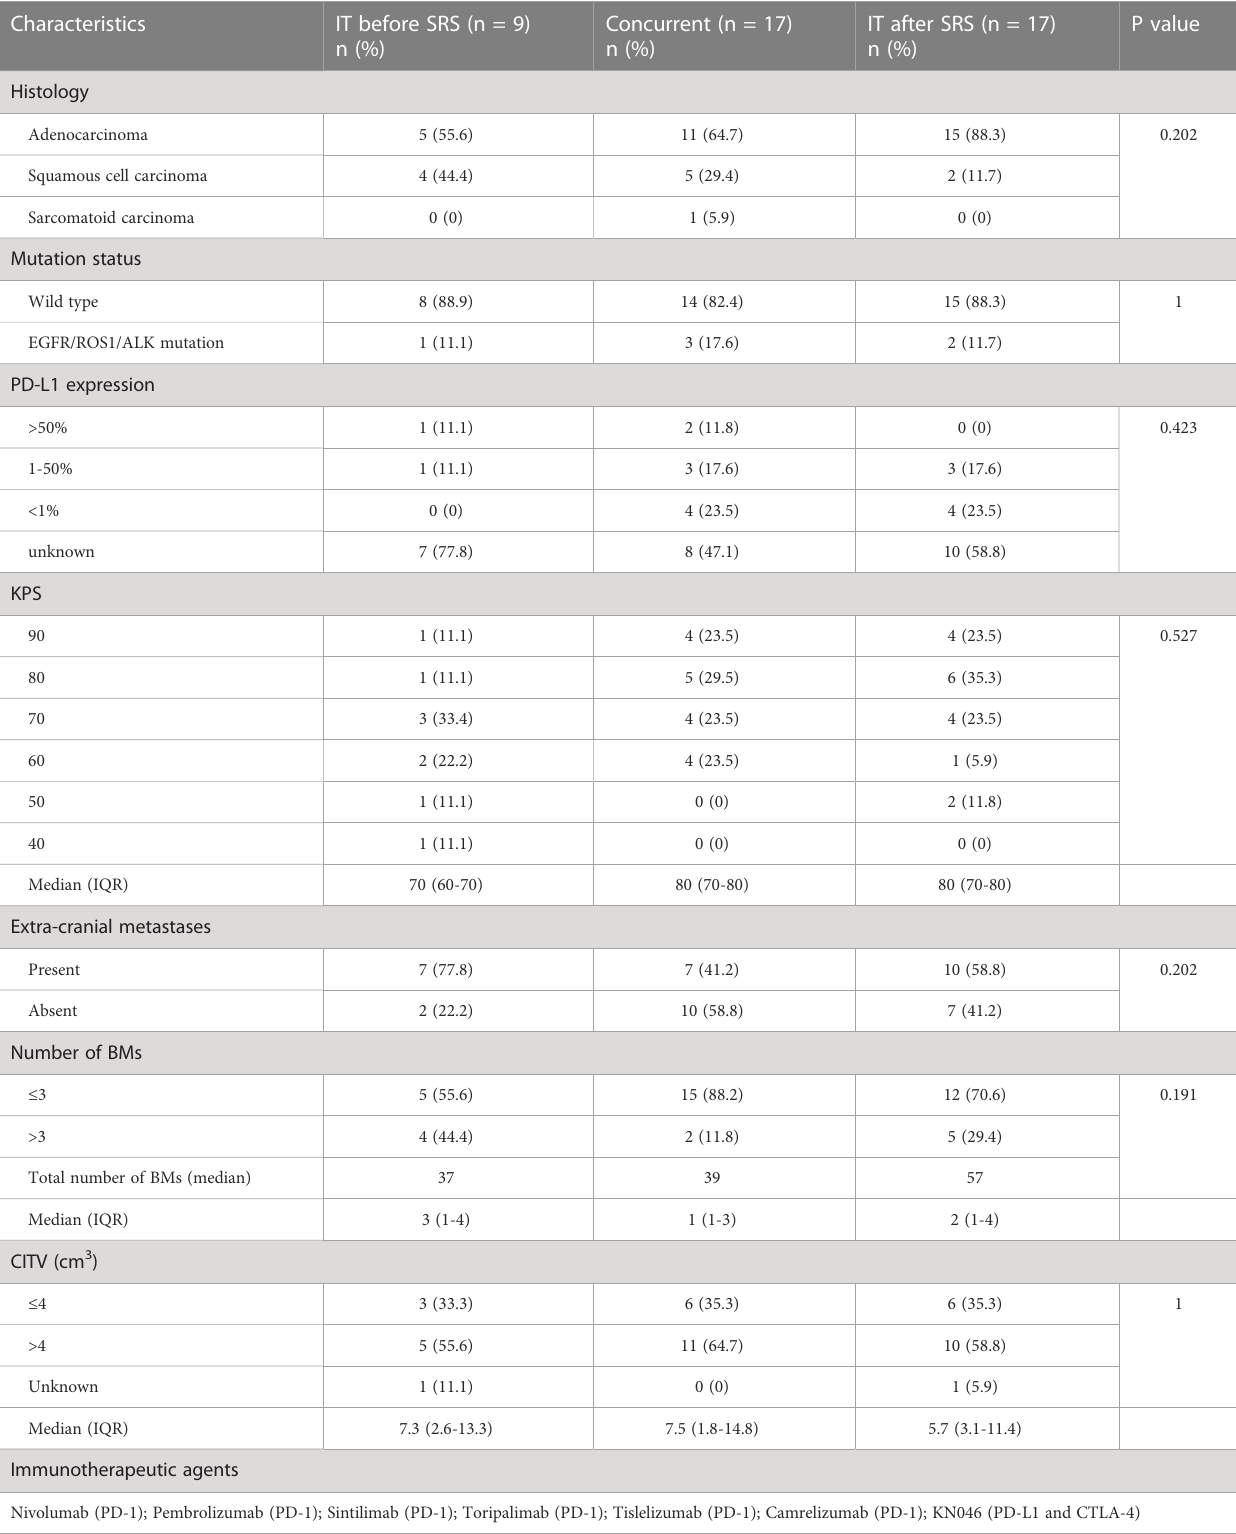
TABLE 3 Relevant characteristics of NSCLCBM patients treated with SRS plus IT.